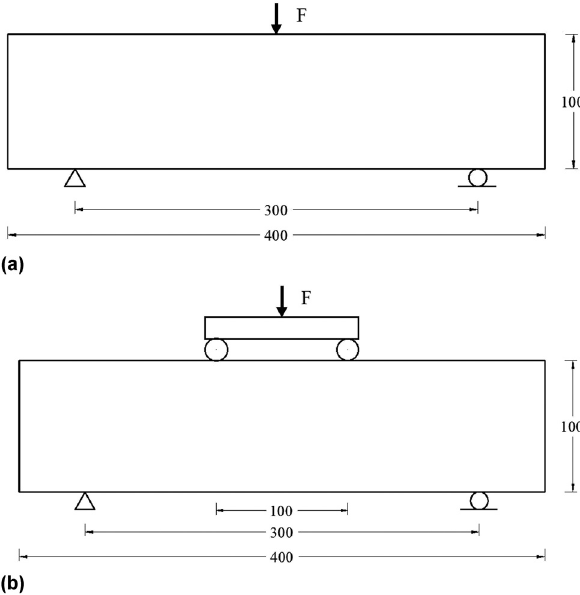
Figure 3: Loading diagram of fl exural test: ( a ) three - point fl exural test and ( b ) four - point fl exural